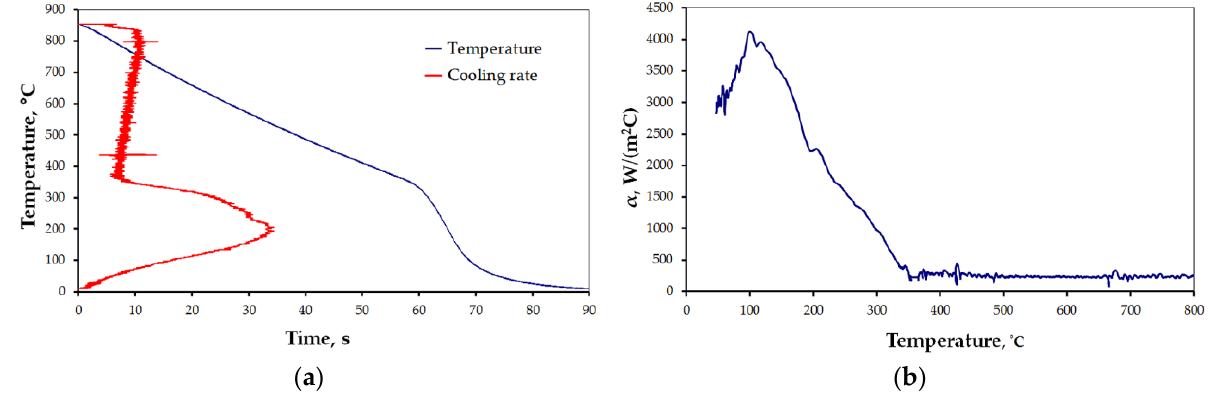
Figure 8. Results of measurement: ( a ) T = f( τ ) and v = f(T) , and ( b ) heat transfer coefficient for settings 3 (Table 1).